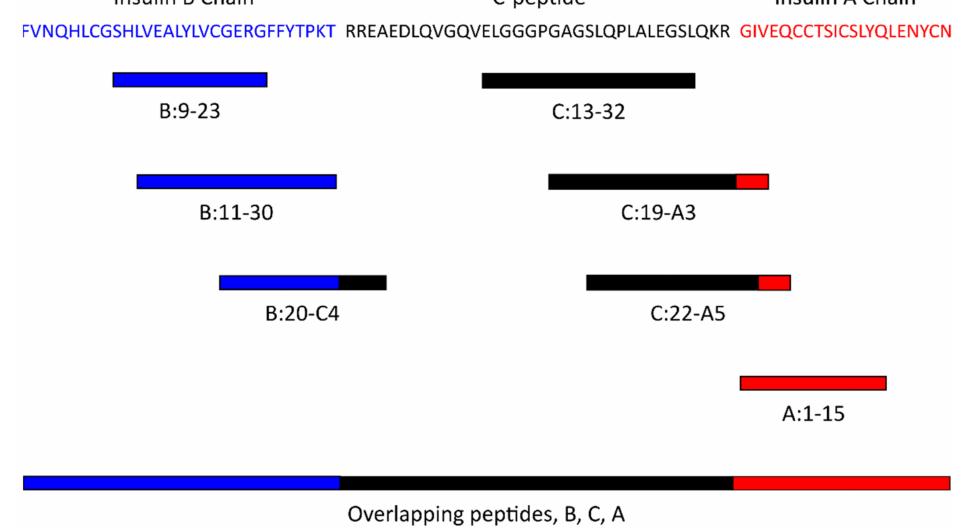
Figure 1. Proinsulin epitopes that induce a regulatory immune response in type 1 diabetes. Displayed is the amino acid sequence of human proinsulin and the locations of peptides recognized by regulatory T cells with accompanying citations. Blue corresponds to amino acids within the B chain, black corresponds to amino acids within the C-peptide, and red corresponds to amino acids within the A chain of proinsulin. Epitopes include B:9-23 [40,42,43,49], B:11-30 [48], B:20-C4 [49], C:13-32 [41], C:19-A3 [41,49,51,94,95], C:22-A5 [41], A:1-15 [49], and overlapping peptides from insulin B chain, C-peptide, and insulin A chain